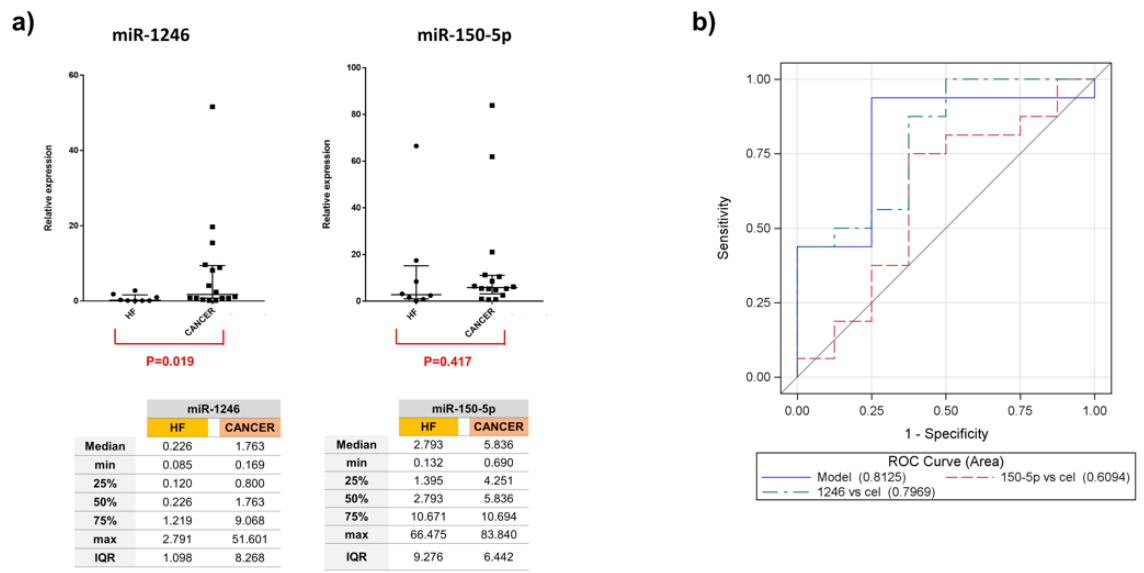
Figure 2. ( a ) Relative expression of miR-1246 and miR-150-5p in all 24 samples report median and interquartile range in the graphs. ( b ) ROC curves and AUC scores for miR-1246, miR-150-5p, and the composite of two miRNAs demonstrate a more superior AUC than each miRNA alone, in dif- ferentiating malignant vs. non-malignant effusion.